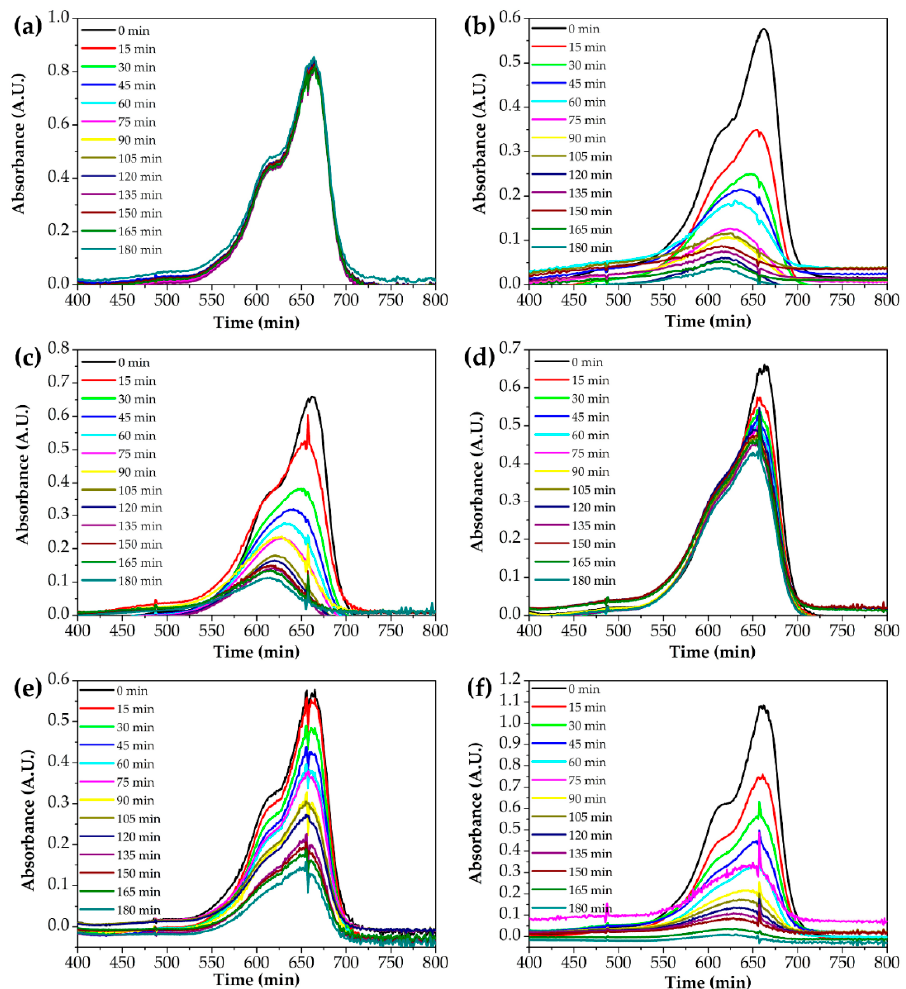
Figure 8. UV-Vis absorption spectra of the photocatalytic degradation of an aqueous methylene blue solution by various photocatalysts (( a ): without catalysts, ( b ): TZ1, ( c ): TZ2, ( d ): TZ3, ( e ): TZ4 and ( f ): TZ5).